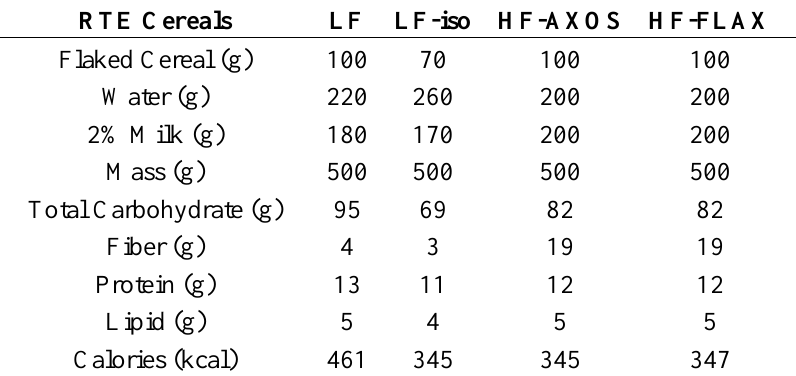
Table 1. Nutrient composition of RTE